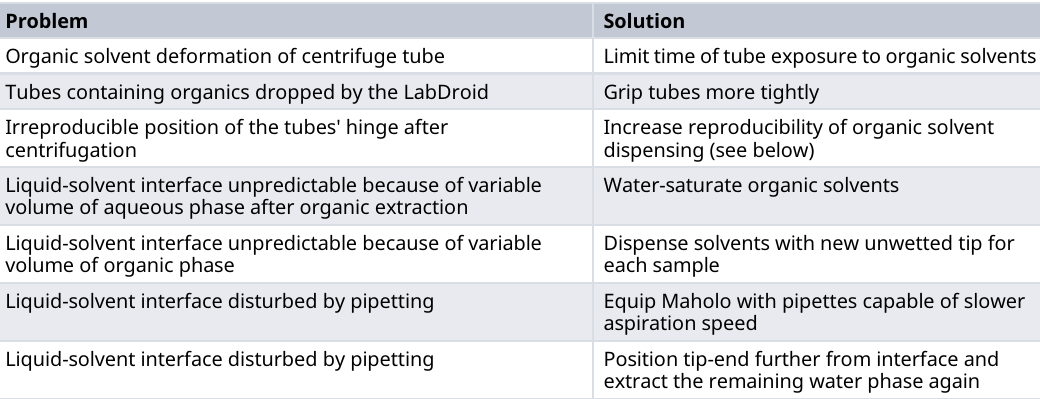
Table 2. Summary of problems encountered and